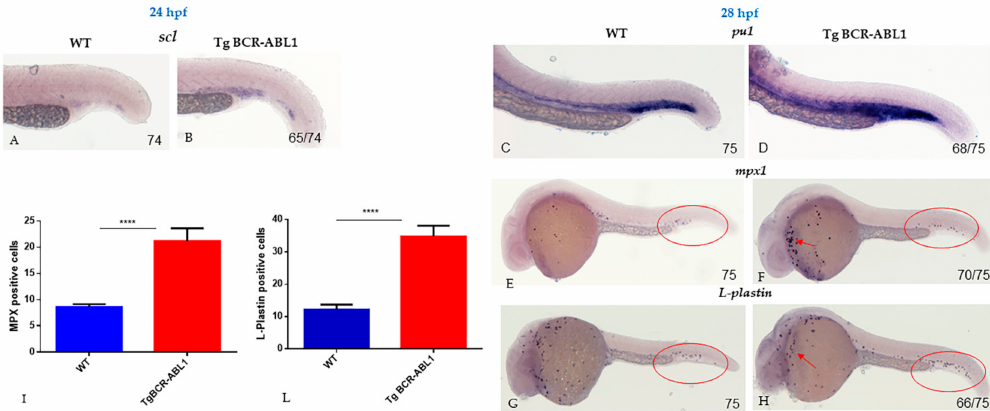
Figure 4. BCR-ABL1 induces a granulopoiesis expansion and granulocytes differentiation. Whole mount in situ hybridization (WISH) of scl at 24 hpf in Wild Type (WT) ( A ) and in Tg BCR-ABL1 ( B ). WISH at 28 hpf for pu1 ( C , D ); mpx1 ( E , F ); and L-plastin ( G , H ) respectively in WT and tg BCR-ABL1 fishes. The experiments were performed in duplicate; numbers in each panel represent total embryos used for the experiment and embryos with the result shown in the image. In each panel, red ovals indicate the positive signals of mpx1 and L-plastin in posterior blood island. Red arrows respectively indicate the mpx 1 ( F ) and L-plastin ( H ) positive cells in the anterior part of the embryos. Statistical analysis of mpx1+ ( I ) and L-plastin+ ( L ) signals counted in posterior blood islands. Unpaired, two-tailed t -test **** p <